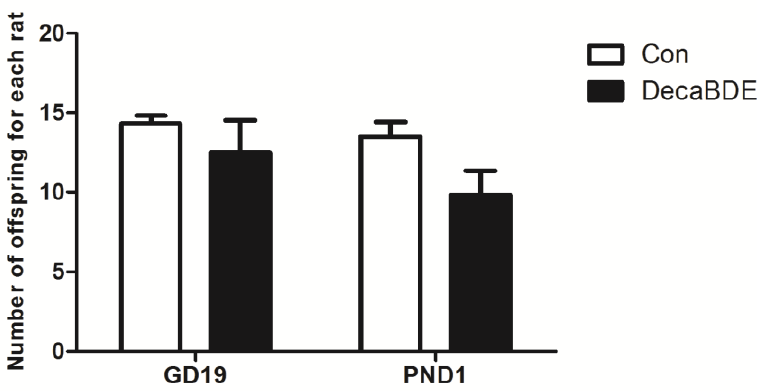
Figure 3. The number of fetuses on gestation day 19 in each rat and the number of pups in each litter on postnatal day 1 in the control (Con) group and DecaBDE-treated (DecaBDE) group. GD19: gestational day 19; PND1: postnatal day 1. p = 0.44, 0.32, respectively.